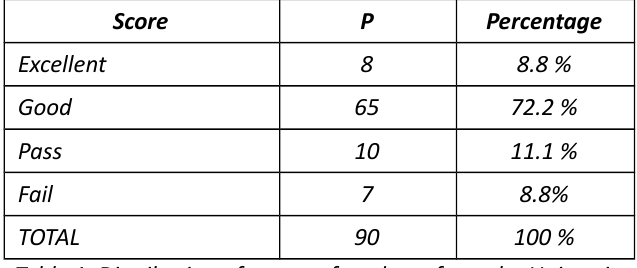
Table 1. Distributon of scores of students from the University of Girona communicaton module (Year